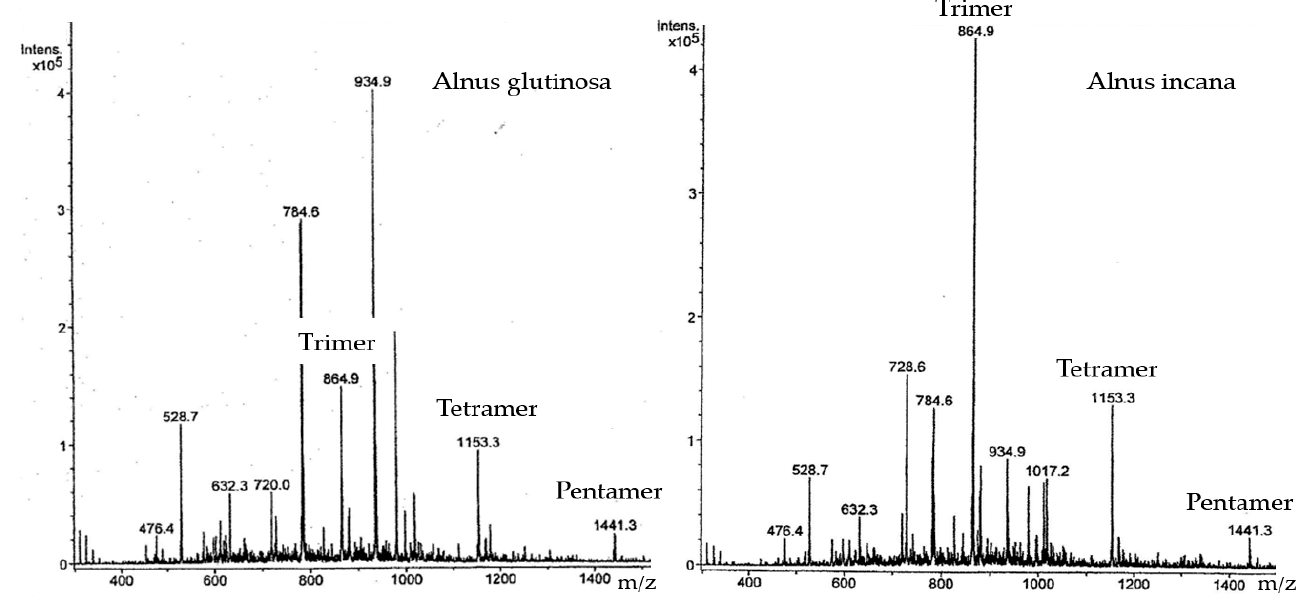
Figure 6. TOF-MS spectra of CTs from Alnus glutinosa and Alnus incana bark.